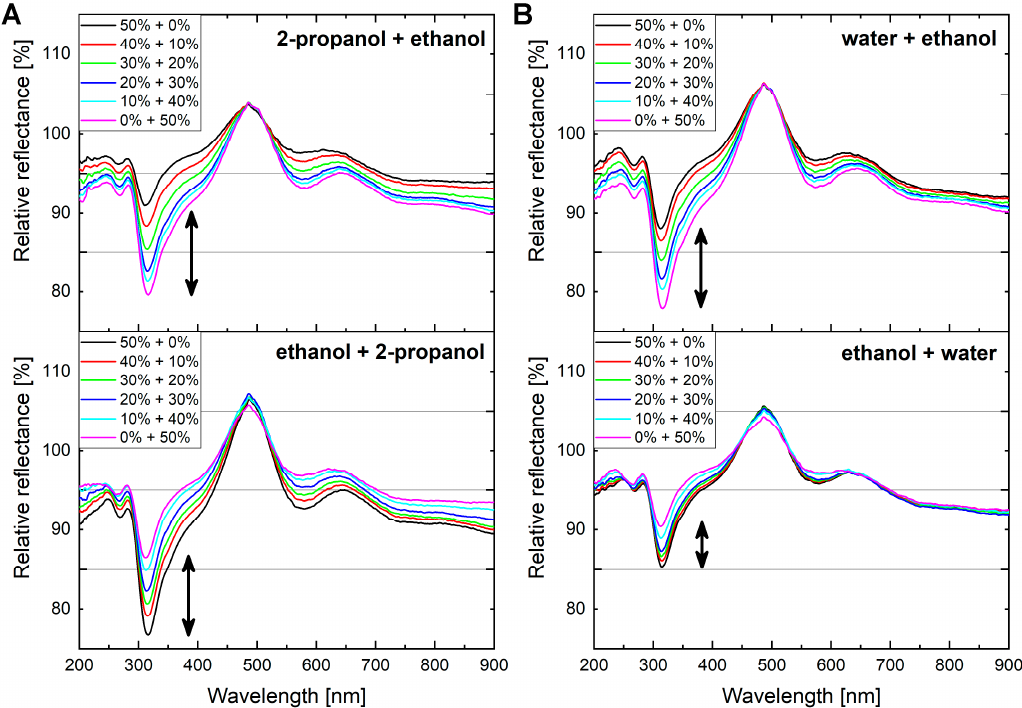
Figure 6. Optical responses of the wings of a P. icarus male specimen when 2-propanol + ethanol and water + ethanol vapor mixtures were applied twice, but with the second in reverse order. ( A ) 2-propanol + ethanol vapor mixtures were applied in reverse order without any issue. ( B ) Water + ethanol vapor mixtures show a significant memory effect compared to the reverse order measurement.